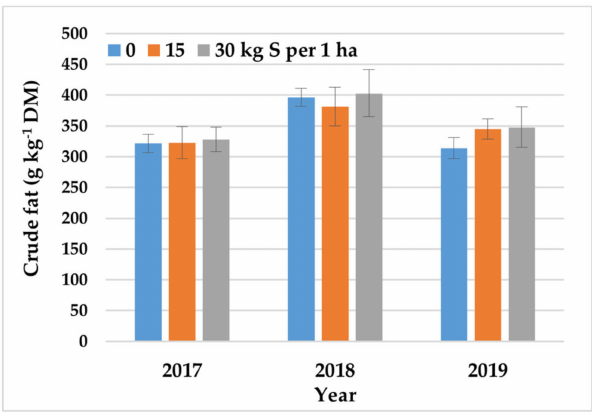
Figure 7. The e ff ect of S fertilization on the crude fat content of crambe seeds across growing seasons (2017–2019). Error bars represent the standard deviation.